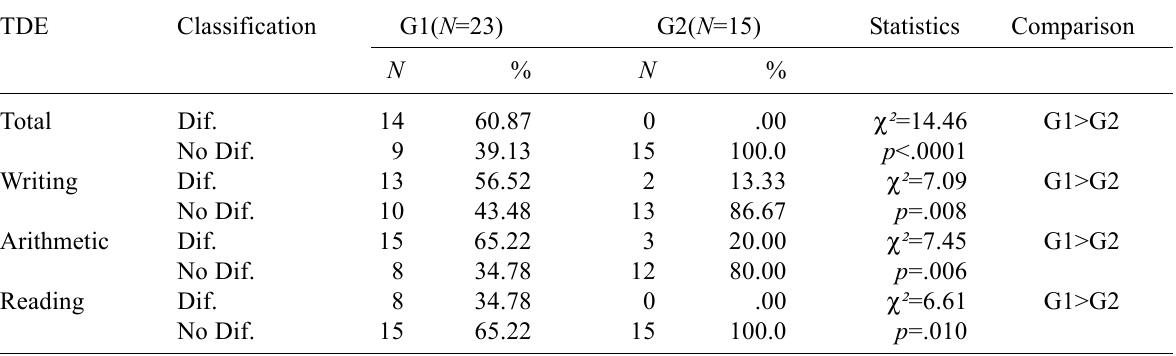
Frequency and Percentages of Children’s Scores on the School Achievement Test (TDE) and its Subscales According to Presence (G1) or Absence (G2) of Behavior and School Performance Difficulties